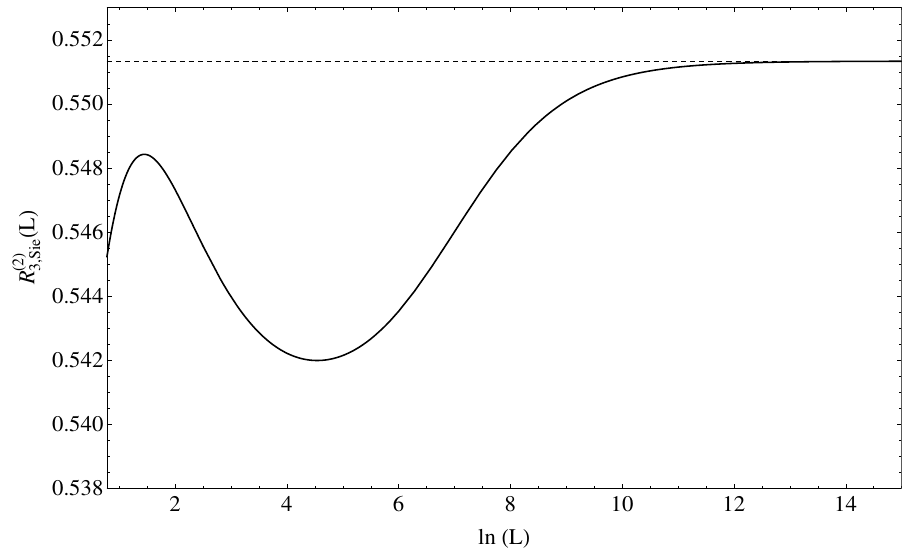
Figure 5 . Plot of R (2) ( L ) for the tachyon vev as a function of level in Siegel gauge. The dashed 3 ; Sie p line represents the conjectured value 3 =(cid:25) .